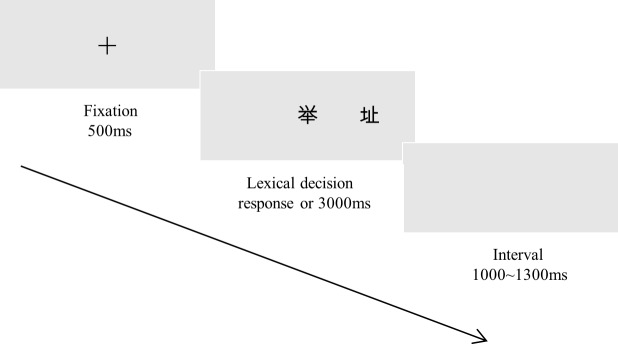
Example of distractor trial sequence.Fig 1 represents a trial of +3° interference condition. The target character (举, lift) was presented at the center of the screen and the distractor character (址, address) was presented at 3° visual angle of right side from the center of the display.